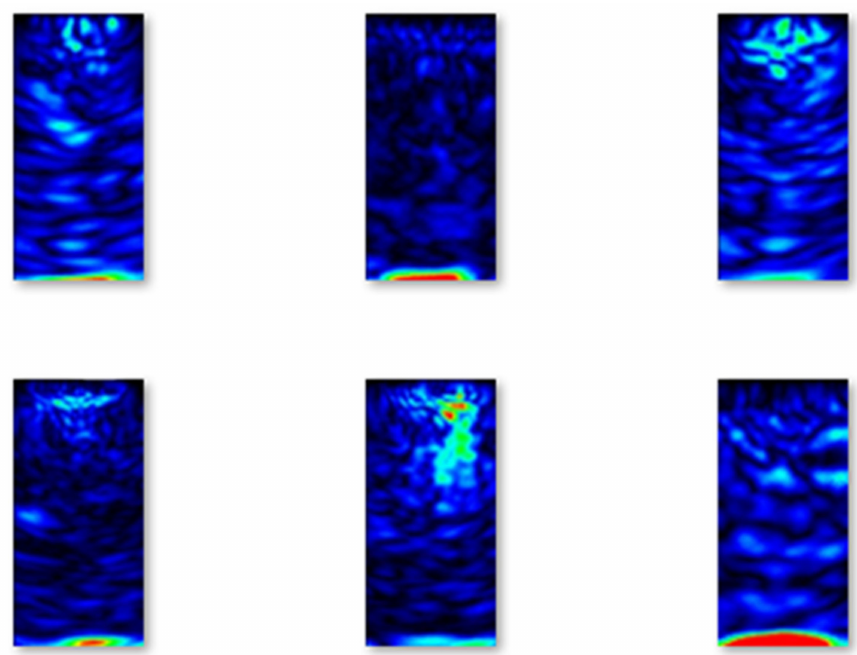
Figure 7. Examples of B-scans without flaws from the validation set.